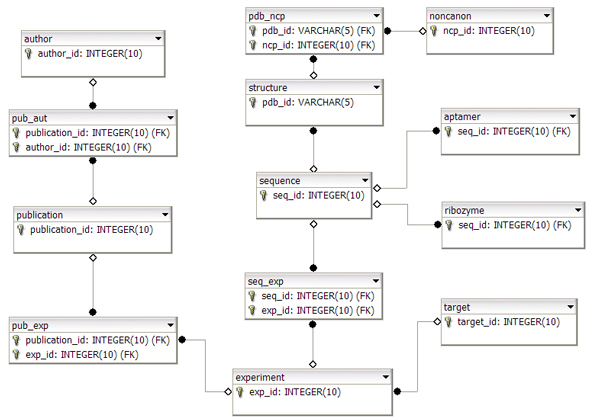
The schema and the dataflow of the RiboaptDB.